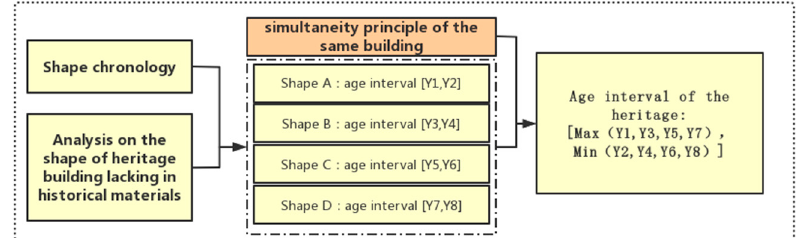
Figure 9. Single building dating.